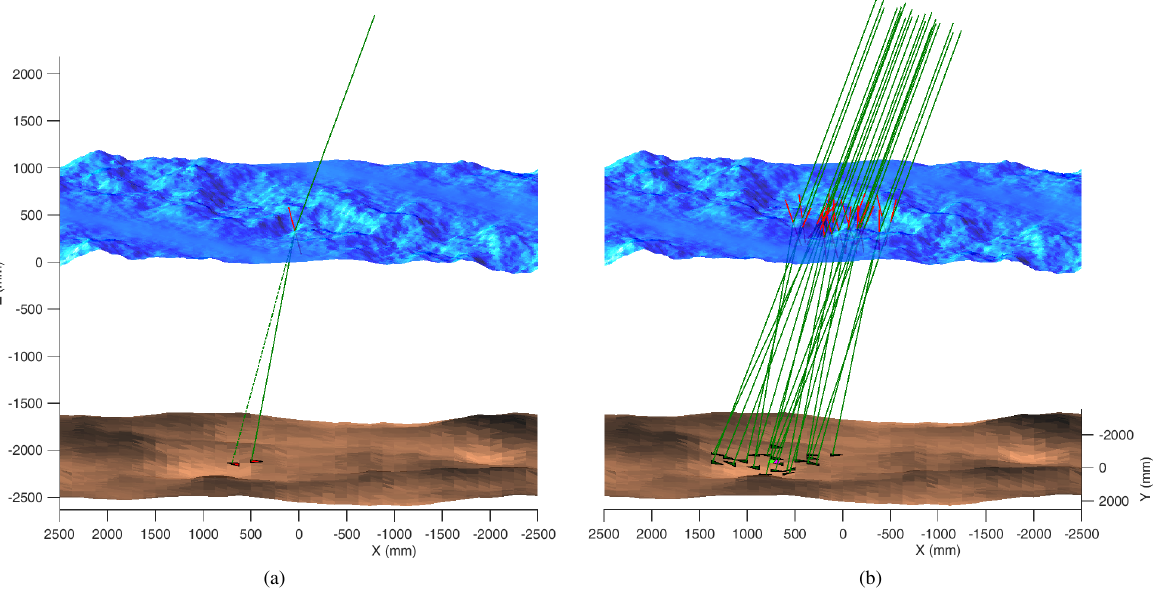
Figure 2: Effects of water surface inclination on bottom point determination: (a) A (infinitely thin) laser ray is refracted at a horizontal and a wavy water surface (dashed vs. solid green line). The surface normal at the point of intersection is shown in red. (b) The refraction is modelled differentially for a finite laser pulse cross section. The irradiance-weighted centroid is shown as neon green sphere (and as magenta sphere for horizontally oriented water surface elements